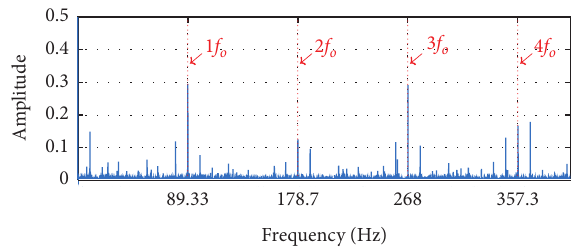
Figure 13: Results of the proposed